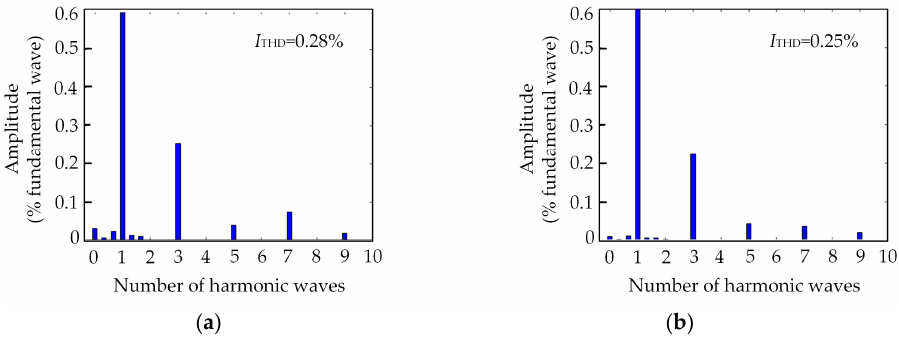
Figure 19. The total harmonic distortion of the output current at cos φ = 0.623 ( N = 8). ( a ) The proposed modulation approach, ( b ) the conventional modulation approach.